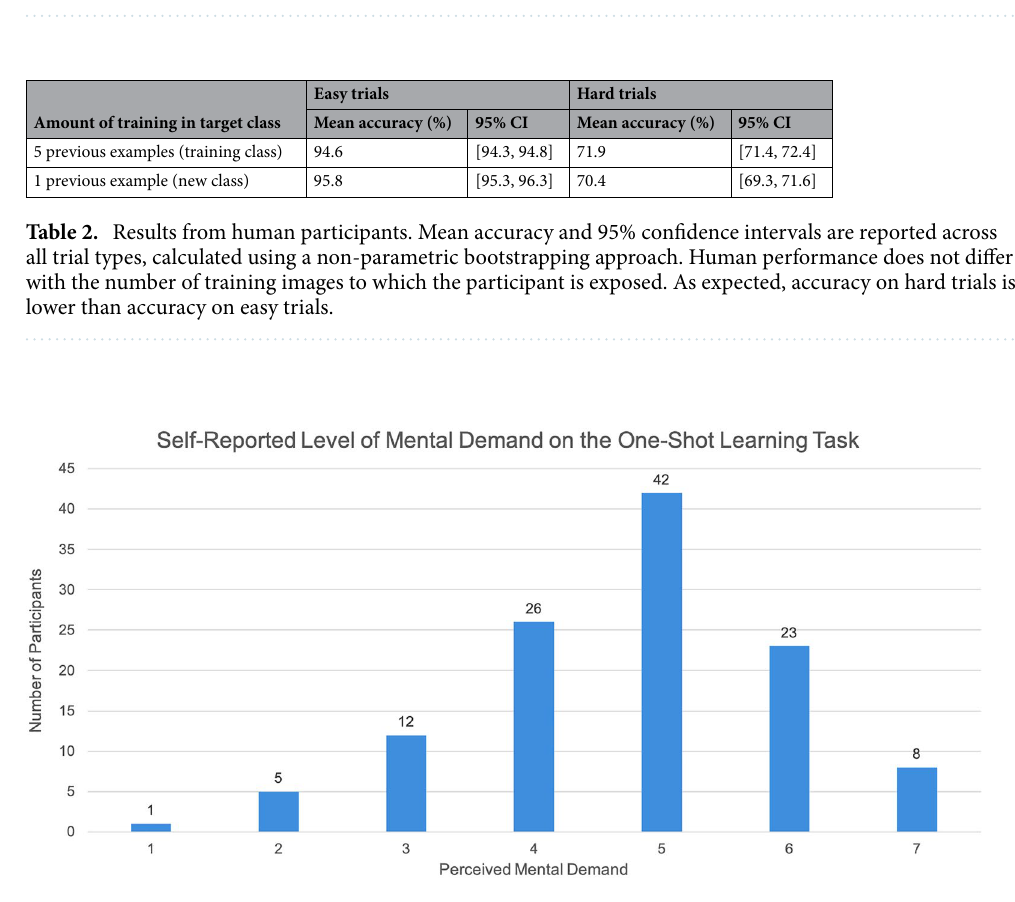
Table 1. Results from a baseline deep learning algorithm: a ResNet 18 architecture pre-trained on mini- ImageNet. Mean accuracy and 95% confidence intervals are reported across all trial types, calculated using a non-parametric bootstrapping approach. While accuracy on the training classes is comparable to human performance, there is a major drop in performance on the new class. This is due to the algorithm’s poor handling of training class imbalance.